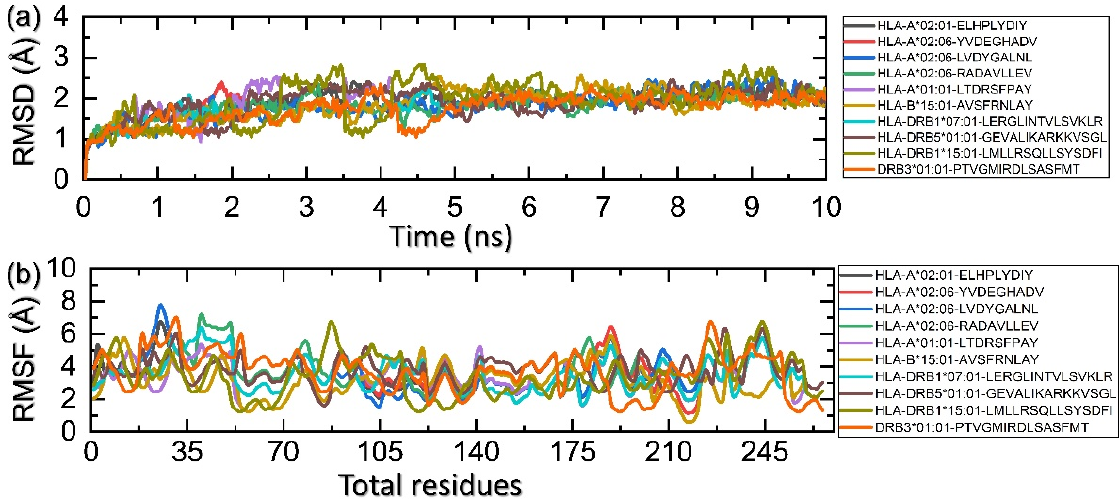
Figure 9. Calculation of RMSD ( a ) and RMSF ( b ) for each HLA and epitope.